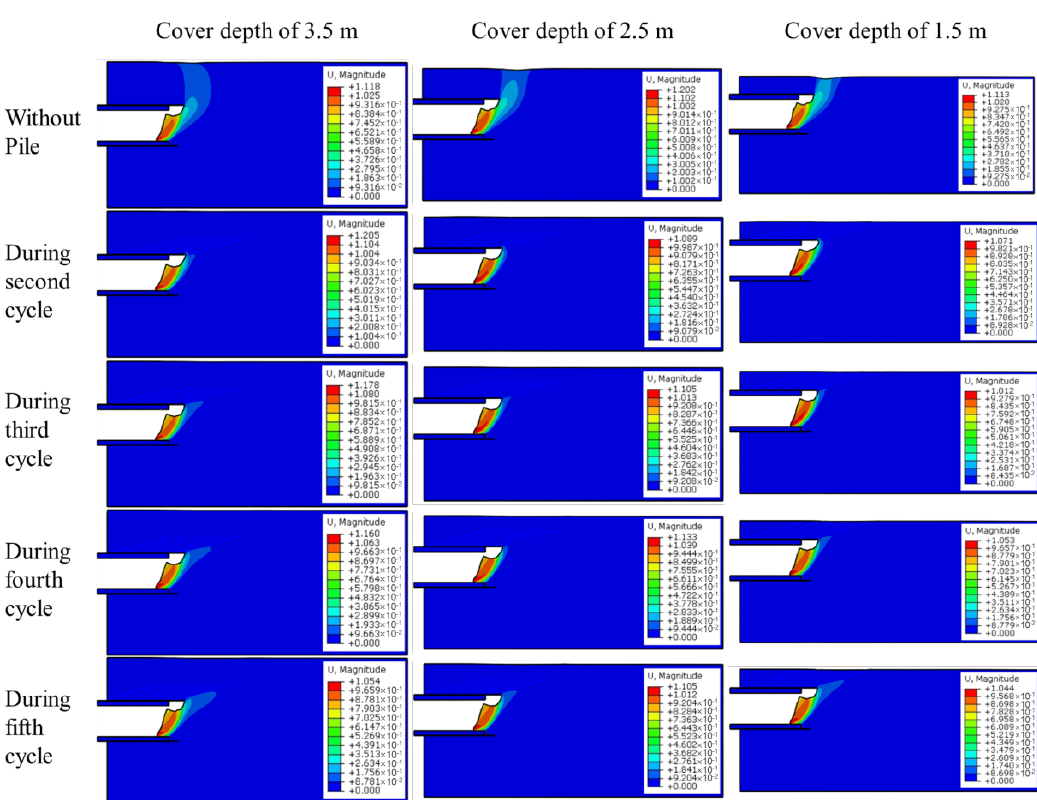
Figure 14. Behavior of tunnel face with respect to time: ( a ) 1.2 s, ( b ) 3 s, ( c ) 4.8 s, ( d ) 6 s.